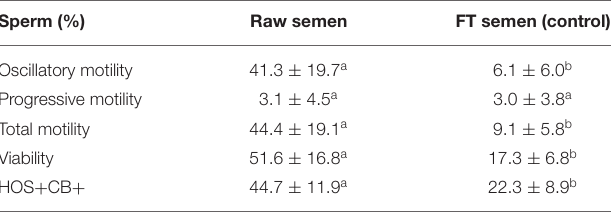
TABLE 2 | Sperm parameters evaluated in raw semen and frozen-thawed (FT) llama semen (untreated control) in ejaculates used for experiment 2.